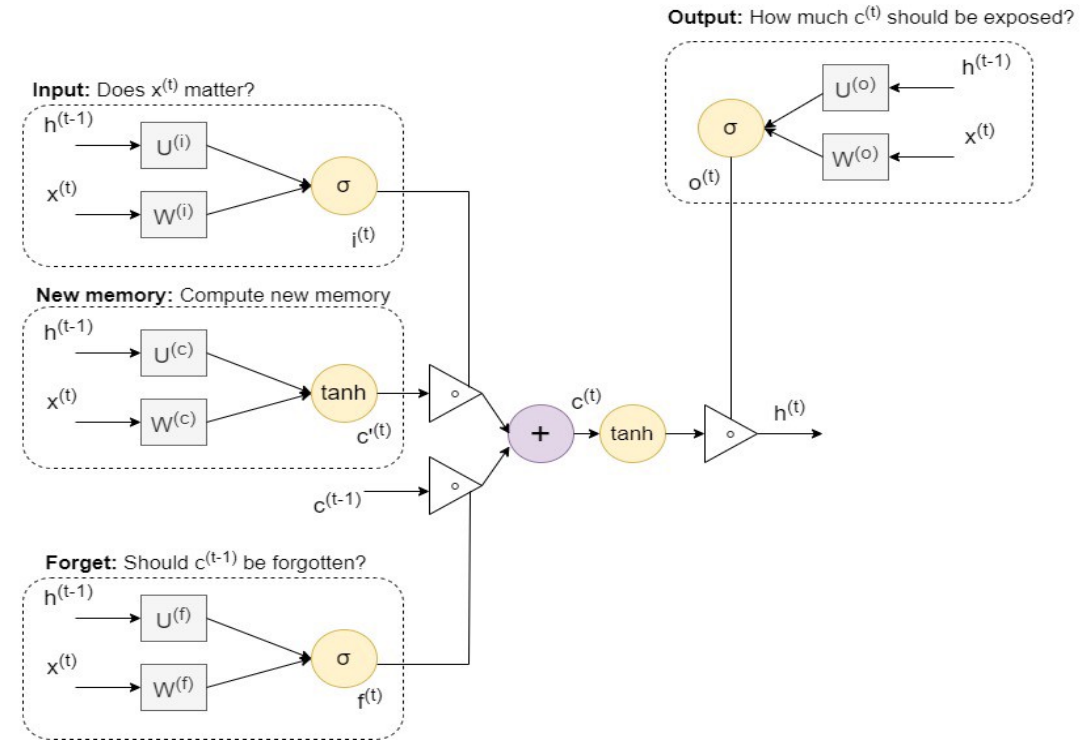
Figure 5. LSTM model.